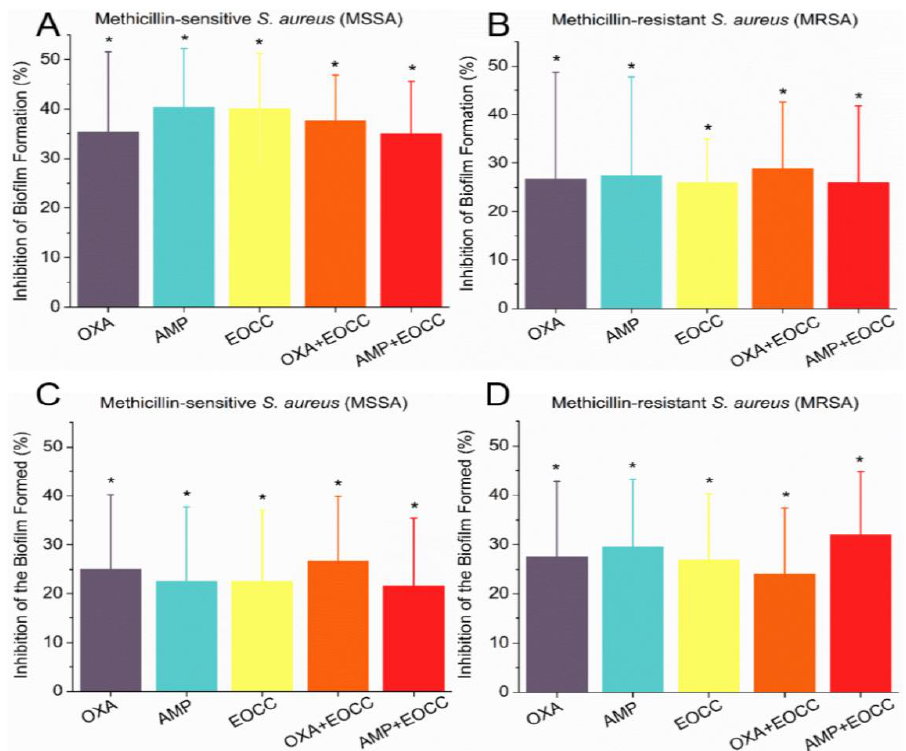
Figure 6. Percentage inhibition of biofilm formation by EOCC, OXA and AMP alone and in combination against the MSSA strain ( A ); percentage inhibition of biofilm formation by EOCC, OXA and AMP in combination and alone against the MRSA strain ( B ); percentage inhibition of mature biofilm for EOCC, OXA and AMP alone and in combination against the MSSA strain ( C ); percentage inhibition of mature biofilm for EOCC, OXA and AMP alone and in combination against the MRSA strain ( D ). The asterisk indicates a non-significant difference ( p > 0.05) according to the t-test.